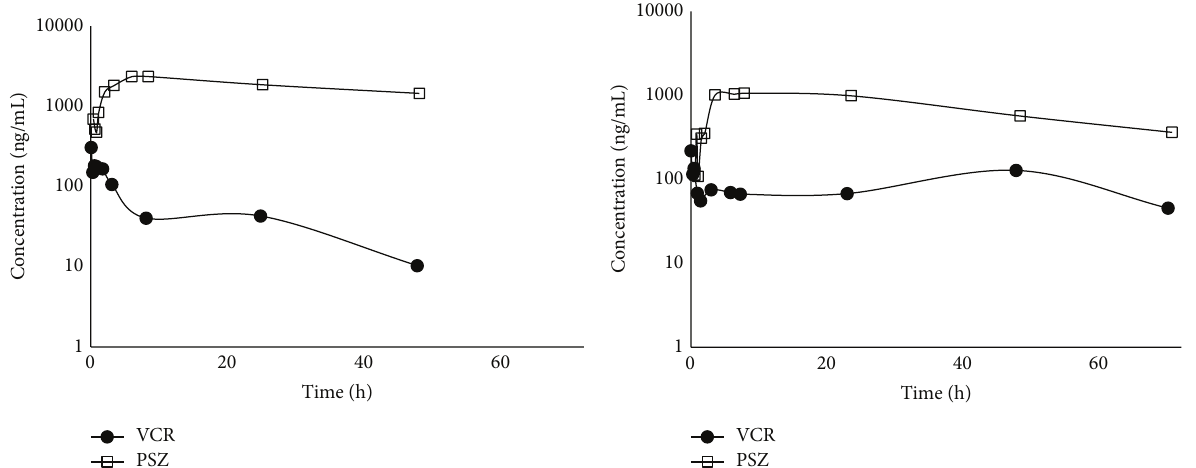
Figure 3: Plasma concentration versus time curves for PSZ and VCR in two rats that were given 40mg/kg PSZ orally followed by i.v. dosing of 0.1 mg/kg VCR 30 minutes